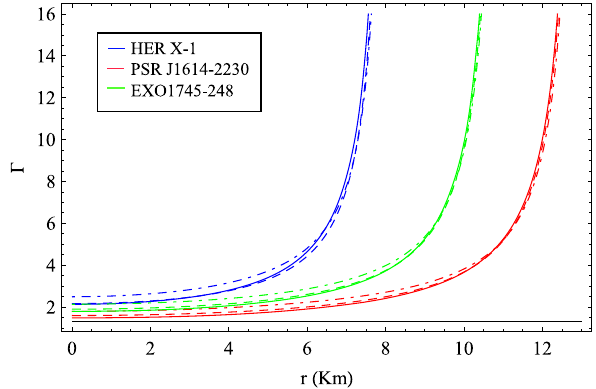
Fig. 28 Radial variation of different forces inside HER X-1. Here red, green, blue and black lines represent gravitational force ( F g ), hydro- static force ( F h ), anisotropic force ( F a ) and electrostatic force ( F e ) respectively. Solid, dashed and dotdashed curves correspond to D = 4, D = 5 and D = 6 respectively